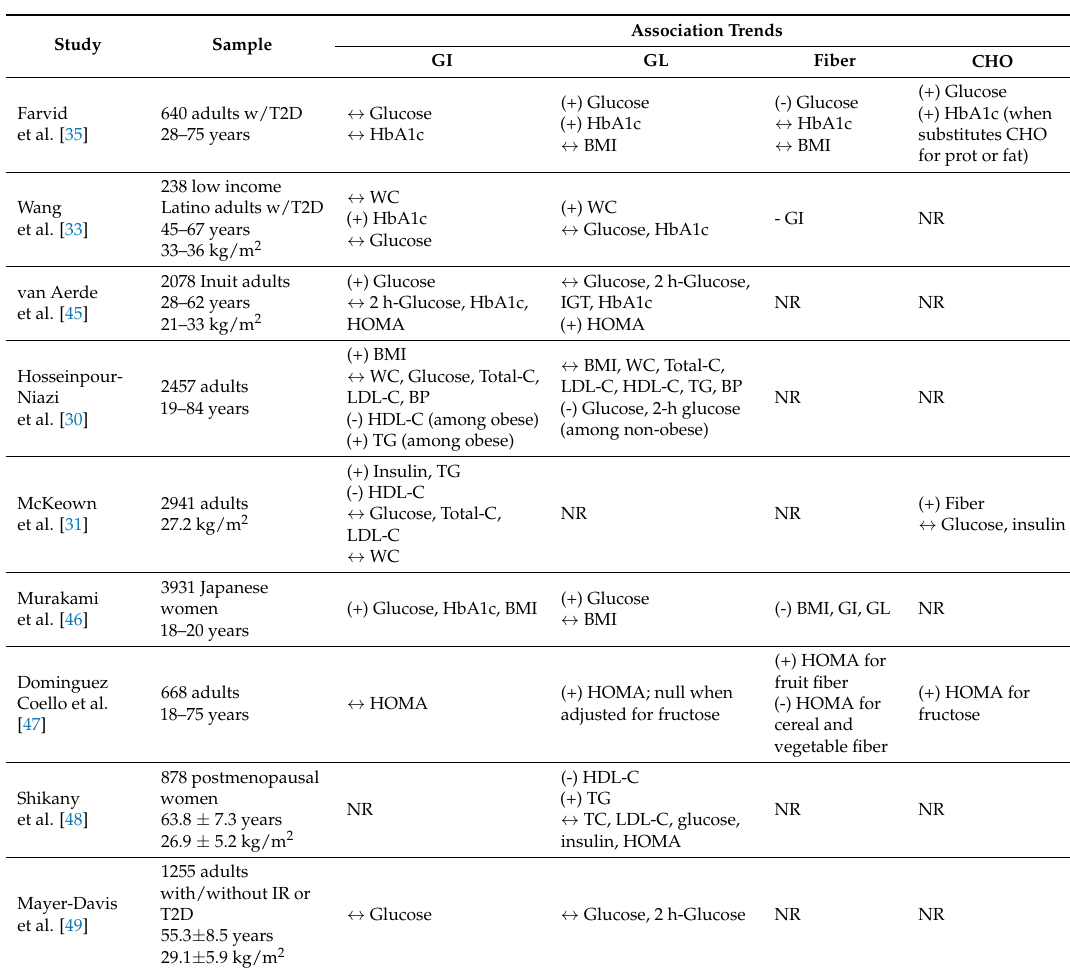
Table 5. Cross-sectional studies assessing the effects glycemic index or glycemic load on markers of glucose homeostasis 1